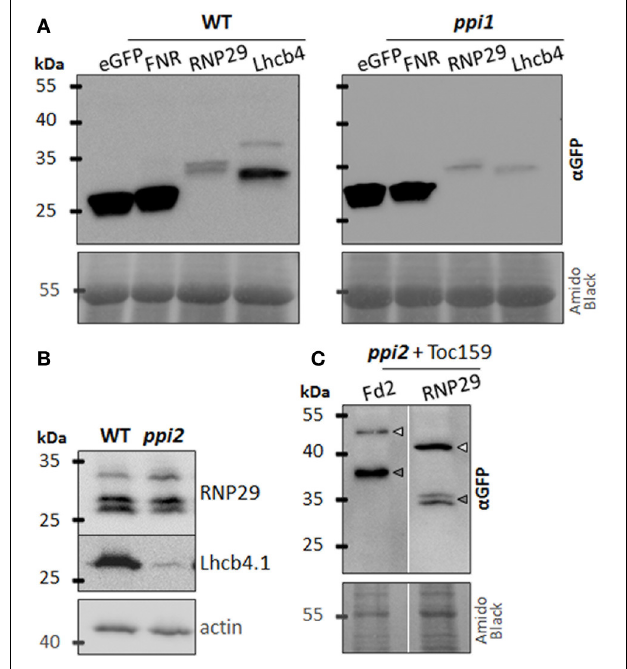
FIGURE 2 | RNP29 import is Toc 159 dependent. (A) Western blot analysis of wild type (WT) and ppi1 protoplasts transiently expressing eGFP or the indicated eGFP fusion protein containing at least the transit peptide of plastid localized FNR, RNP29, or Lhcb4. Detection was achieved by an anti-GFP antibody. The amido black stained membrane is shown as loading control. (B) Abundance of cpRNPs 29A (At3g53460, upper band) and 29B (At2g37220, lower double band) and Lhcb4.1 (At5g01530) in total protein extracts from wild type (WT) and ppi2 seedlings. In total 150 μ g protein was loaded and actin was used as loading control. (C) Western blot analysis of reconstituted import of eGFP fusion proteins Fd2 1 − 100 :eGFP and RNP29 1 − 100 :eGFP in ppi2 protoplasts cotransformed with full length Toc159. The reporter protein was detected with an anti-GFP antibody; arrows indicate the positions of preproteins (light gray) and mature proteins (dark gray). The amido black stained membrane is shown as loading